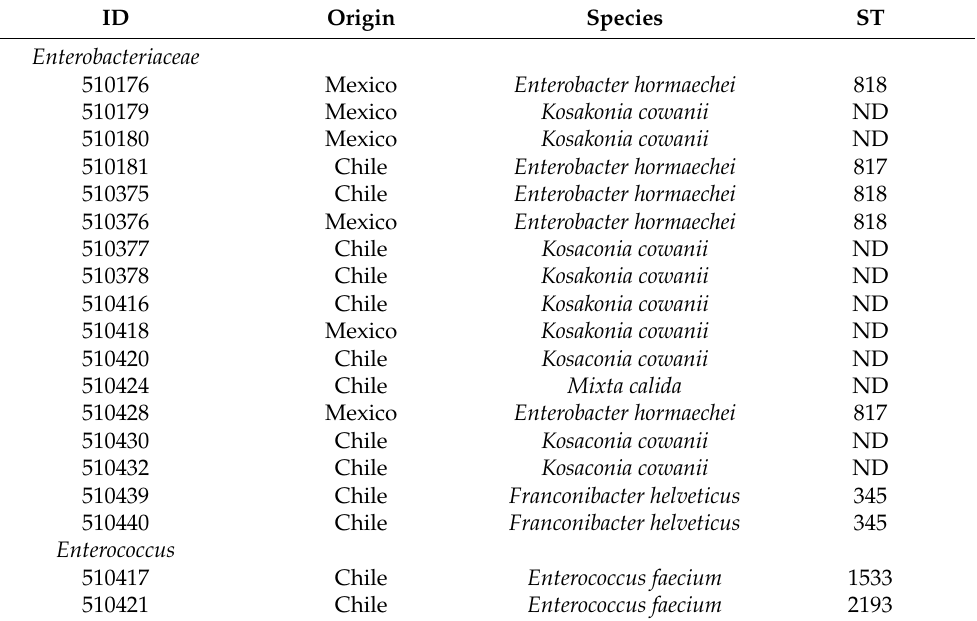
Table 1. Identification of the Enterobacteriaceae and Enterococcus species found in the